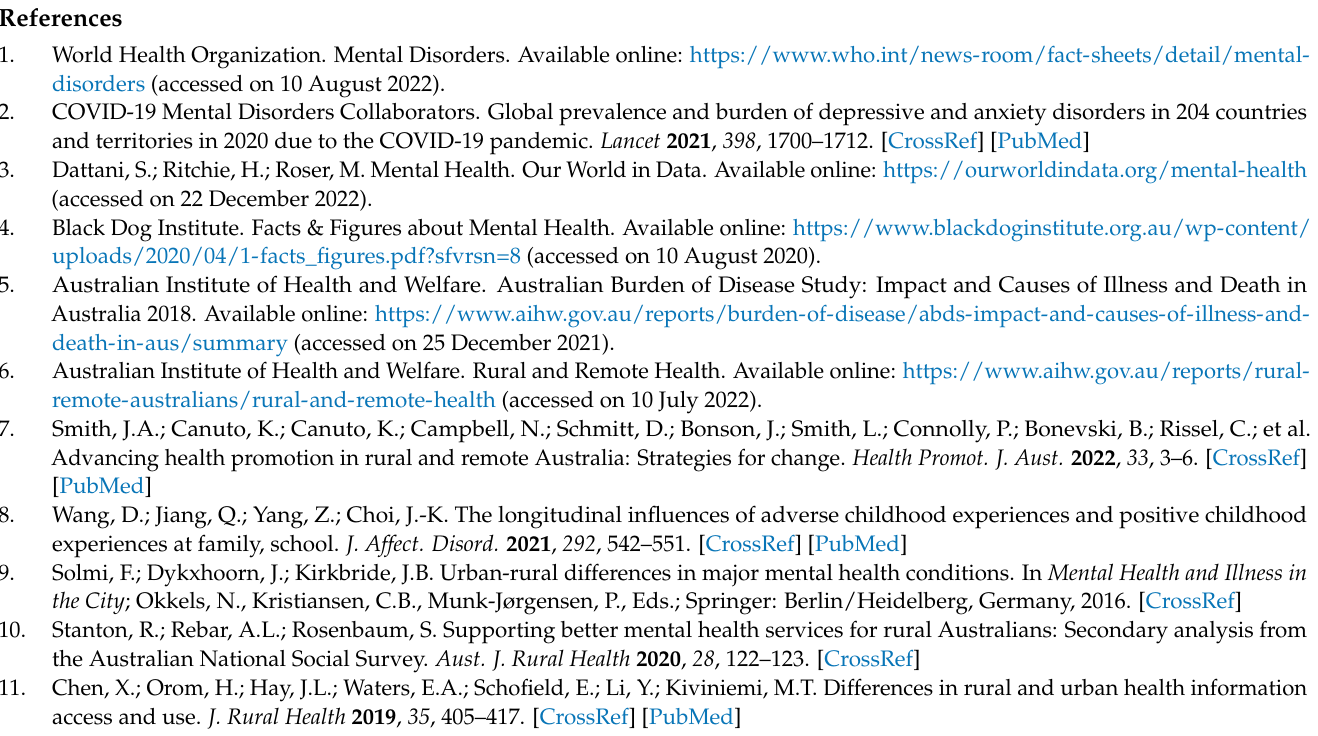
Figure S2: Begg’s funnel plot: anxiety; Figure S3: Begg’s funnel plot: depression or anxiety; Figure S4: Begg’s funnel plot: urban; Figure S5: Begg’s funnel plot: rural; Figure S6: Begg’s funnel plot: overall; FigureS7: Sensitivity analysis: pooled estimate of depression, anxiety and depression or anxiety disorders without studies of wide range of age groups; Figure S8: Sensitivity analysis: pooled estimate of urban area and rural areas without studies of wide range of age groups; Figure S9: Sensitivity analysis: pooled estimate of depression, anxiety and depression or anxiety disorders without studies of “at-risk” participants; Figure S10: Sensitivity analysis: pooled estimate of urban area and rural areas without studies of “at-risk” participants; Figure S11: Sensitivity analysis: pooled estimate of depression, anxiety and depression or anxiety disorders without studies of that illustrated insignificant results; Figure S12: Sensitivity analysis: pooled estimate of urban area and rural areas without studies of that illustrated insignificant results; Figure S13: Trim and Fill analysis: one imputed study; Table S1: Base characteristics of the 17 estimates from the 10 studies included in the